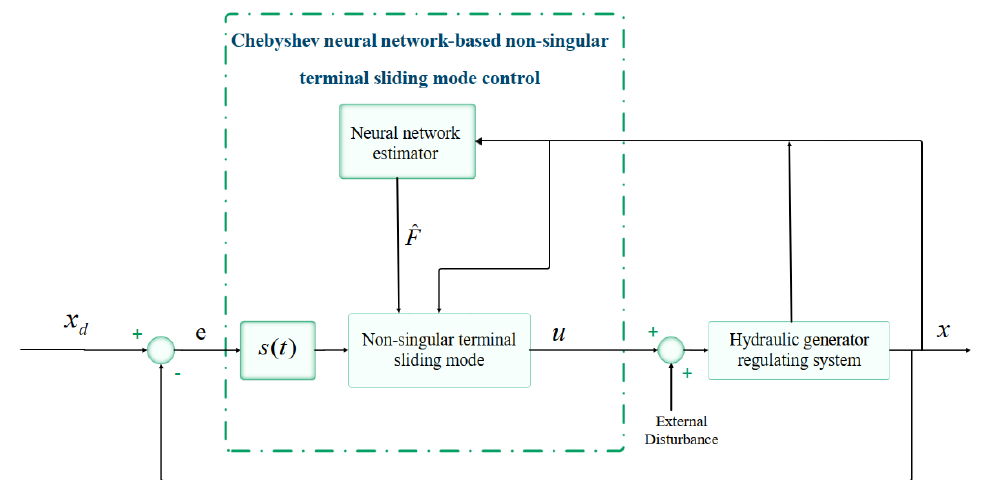
Figure 5. Scheme of ChNN-based non-singular FTSMC.